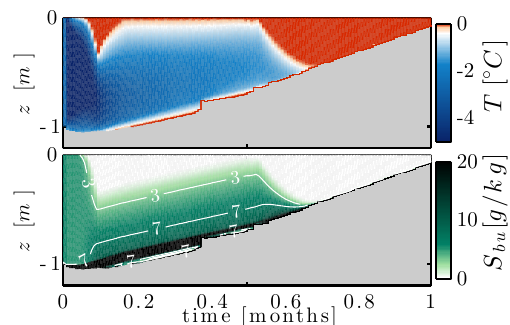
Figure 6. Temperature and bulk salinity evolution of the idealized flushing experiment using the default model set-up (experiment set- up in Sect. 3, model set-up in Table 1). Plot background is grey. The 3 and 7gkg − 1 contour lines are